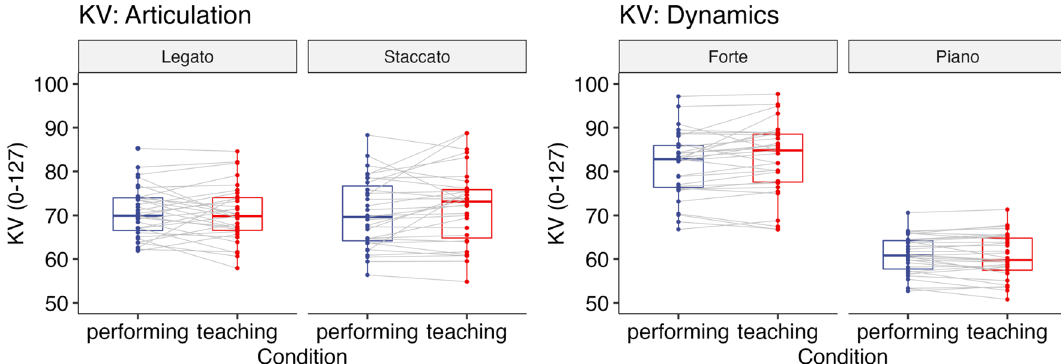
Figure 4. Experiment 1: KV (0–127) when playing the piece with either articulation (left) or dynamics (right). Each box indicates the IQR with the median, and whiskers extend to a maximum of 1.5 × IQR beyond the box. Significance levels: * < 0.05, ** < 0.01, *** <